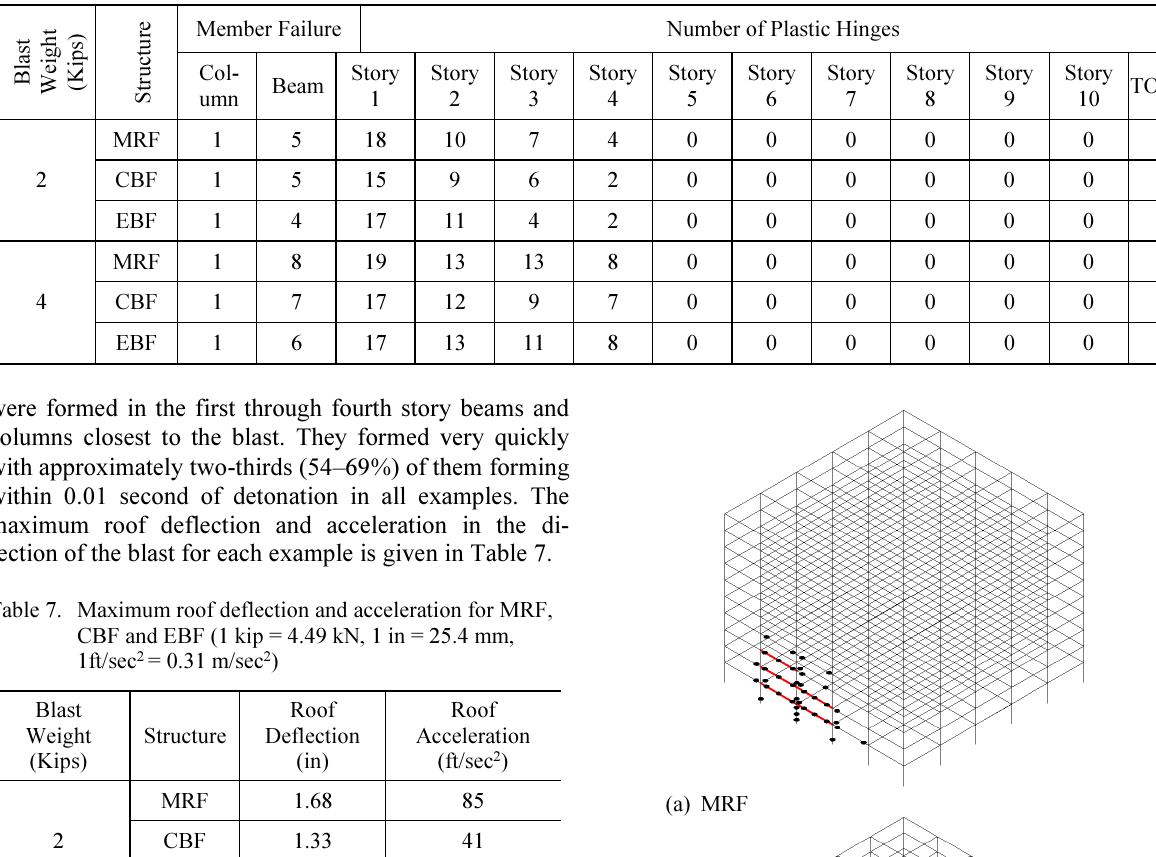
Table 6. Plastic hinge and member failure for MRF, CBF and EBF (1 kip = 4.49 kN)